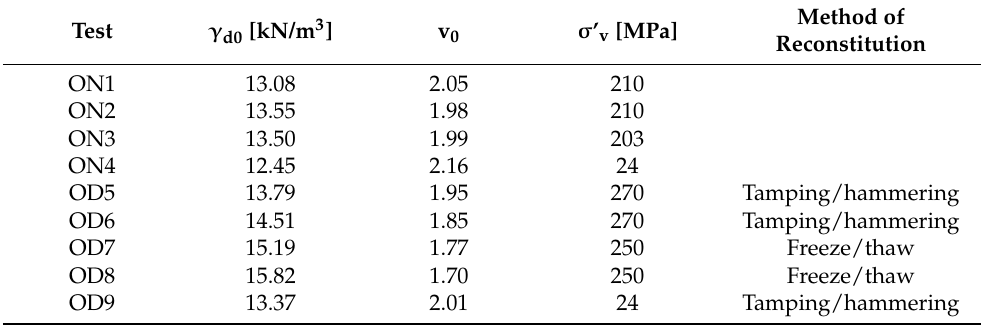
Table 1. Details of the oedometer tests (ON Natural, OD Destructured).